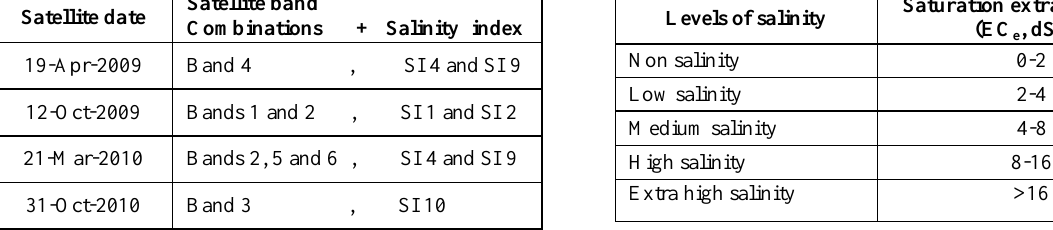
Table 4. Different set of band combinations.